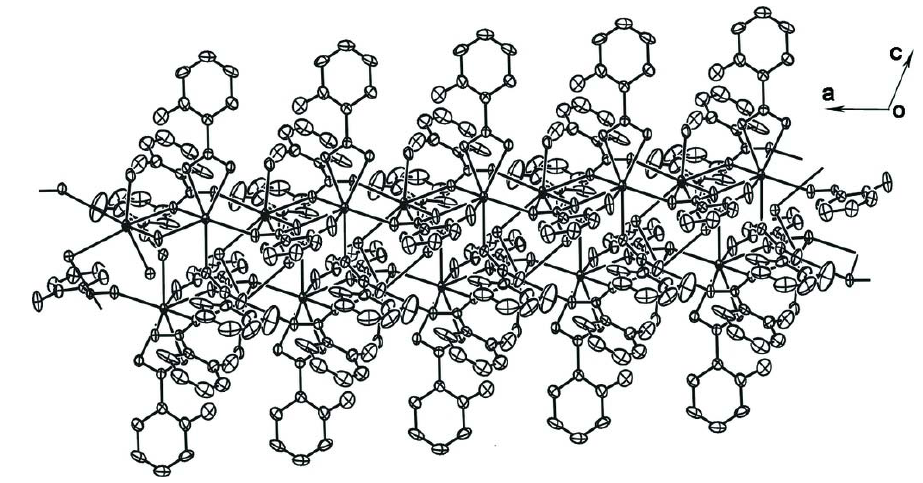
Figure 2 View of one-dimensional chain structure extending along the [100] direction.